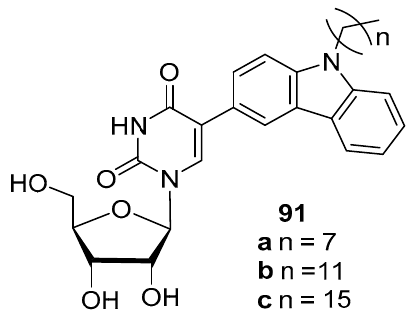
Figure 53. Nucleosides functionalized with carbazole [101].